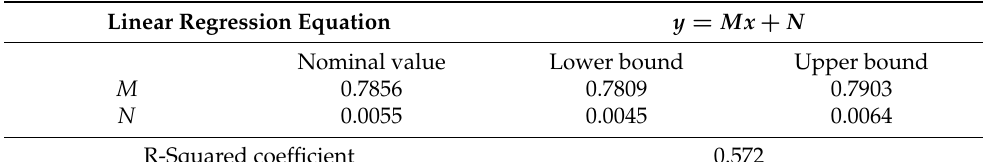
Table 3. Linear regression over sampled data vs. reconstructed data considering the Laplace Wavelet estimation.